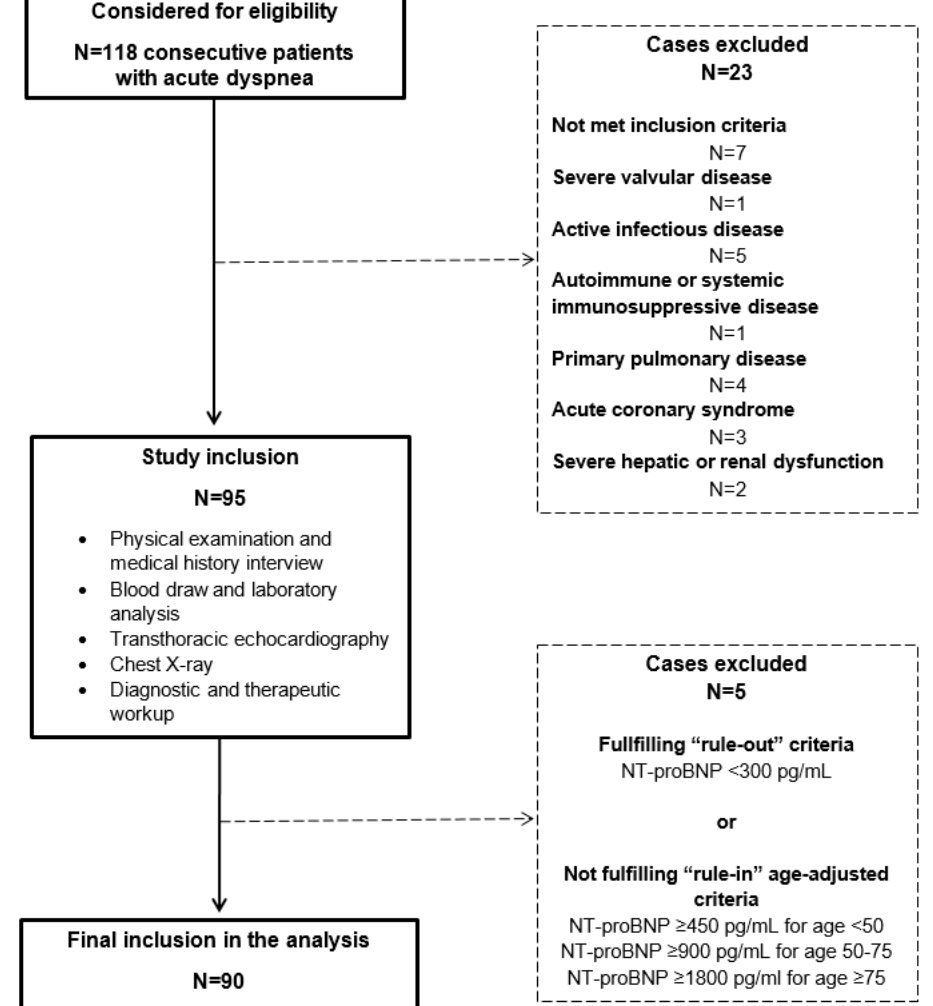
Figure 1. Flowchart of the CATSTAT-HF study.